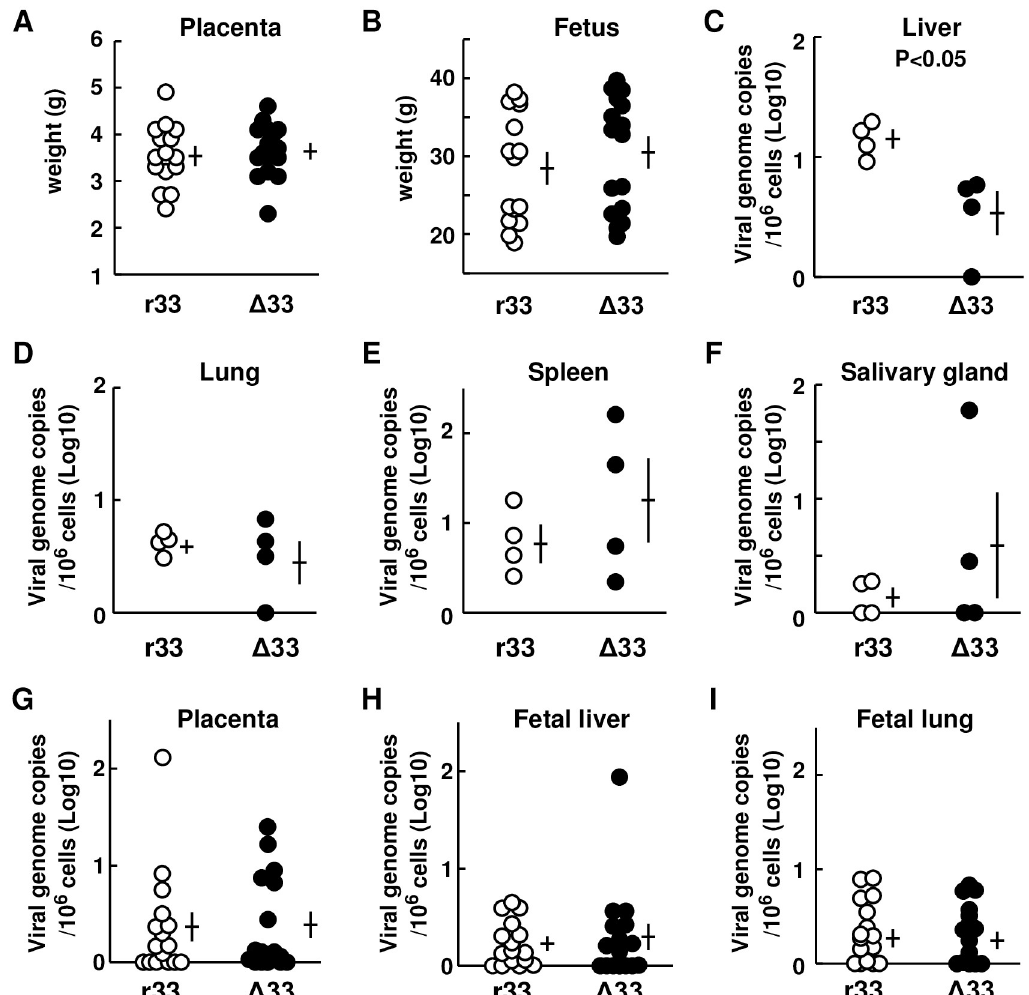
Fig 8. Viral loads in organs at 3 weeks after infection of dams at 4 weeks’ GA. (A, B) Pregnant guinea pigs (Hartley) at 4 weeks’ GA were infected s.c. with GPCMV r33 or Δ 33 (n = 4 each; 2x10 7 IUs/animal) and sacrificed at 3 weeks p.i. to collect specimens. Comparison of the weights of placentas (A) and fetuses (B) from dams infected with r33 (open circles) or Δ 33 (closed circles). Each circle indicates one placenta or fetus. Means and SEMs of the weights are shown. (C-F) GPCMV genome copies per 10 6 cells of the livers (C), lungs (D), spleens (E), and salivary glands (F) obtained from the dams infected with r33 (open circles) or Δ 33 (closed circles). Means and SEMs of genome copies are shown. (G-I) GPCMV genome copies per 10 6 cells of the placentas (G), fetal livers (H) and fetal lungs (I) obtained from fetuses of the dams described above. Means and SEMs of genome copies are